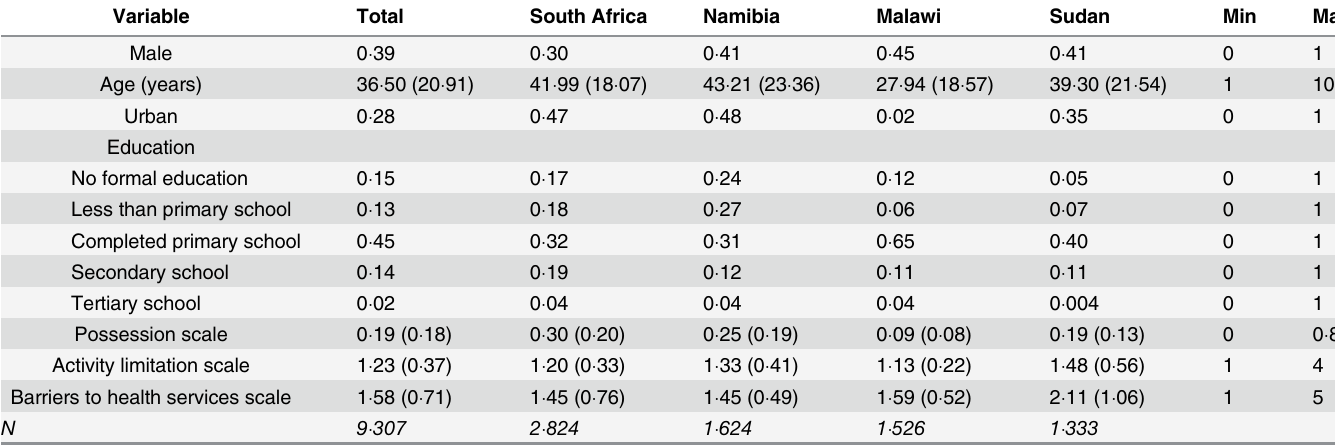
Table 1. Sample characteristics, by